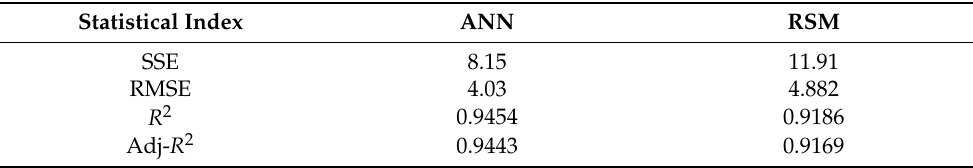
Table 7. Comparison of the ANN and RSM model adequacies for formaldehyde removal by the Fenton process.